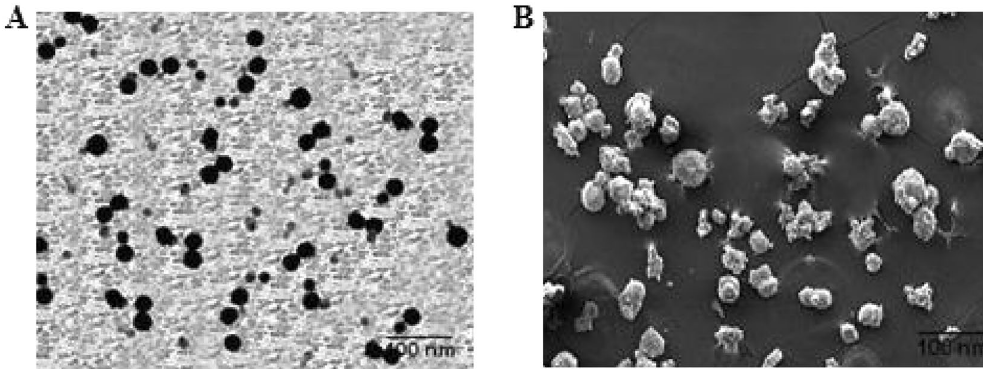
Figure 5. Electron Microscopic analysis of ICN-K04: ( A ) Transmission electron micrographs of ICN- K04shows particle size of 50–80 nm, ( B ) Scanning electron micrographs. Scale bar-100 nm.